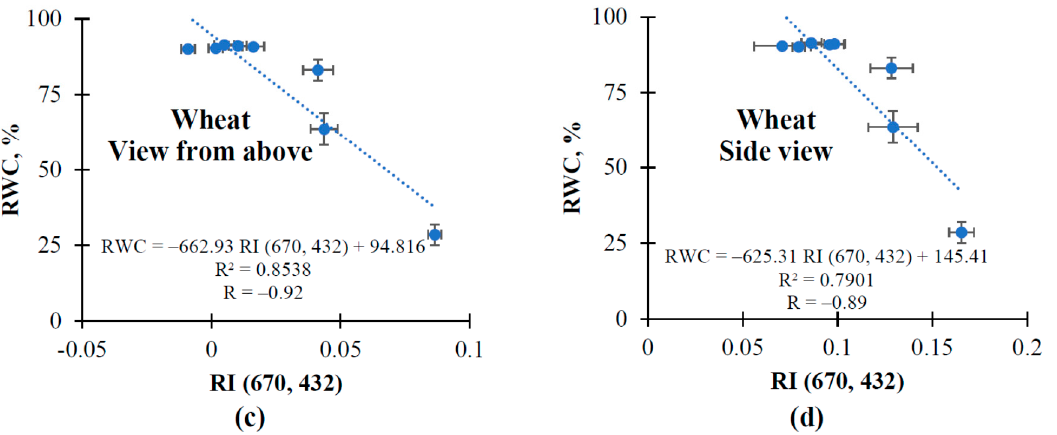
Figure 6. Scatter plots between RWC and RI (670, 432) which were measured in pea from the view from above ( n = 14) ( a ), in pea from the side view ( n = 14) ( b ), in wheat from the view from above ( n = 8) ( c ), and in wheat from the side view ( n = 8) ( d ). Corresponding averaged values from Figures 2 and 5 were used for the scatter plots. R and R 2 are correlation and determination coefficients, respectively. Correlation coefficients were significant for all considered causes.